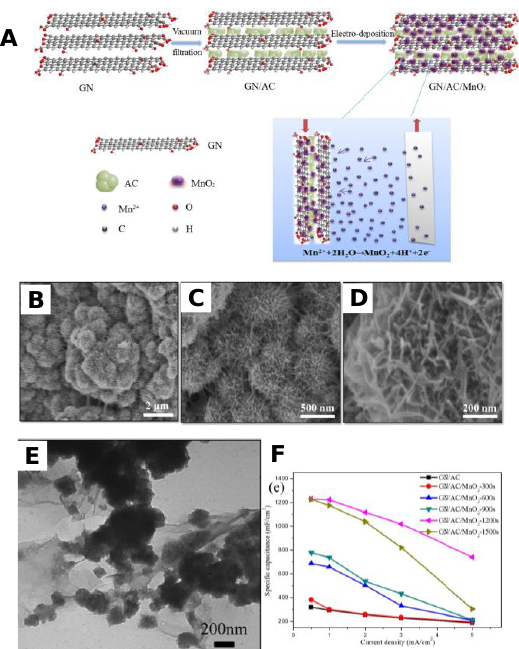
Figure 4. ( A ) Schematic illustrations for the preparation process of GN/AC/MnO 2 composite electrodes, ( B – D ) GN/AC/MnO 2 -1200 s composite films at high magnifications, ( E ) TEM image of GN/AC/MnO 2 -1200 s composite films, and ( F ) specific capacitances of electrodes at various current densities. Reproduced with permission from reference [54]. Copyright © 2017, The Author(s).